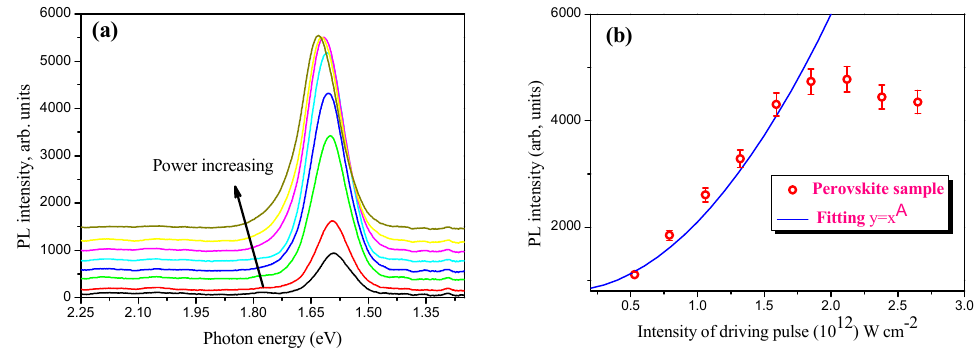
Figure 4. Power − dependent PL signal excited in the thin film mixed perovskite. ( a ) Power-dependent blue − shifted PL signal at the wavelength of 779.8 nm to 758.1 nm. The black arrow shows blue-shift of the PL peak. ( b ) Quadratic dependence (A = 2) of the PL emission integrated intensity on the intensity of the driving laser pulses at low excitation power is observed at 50 kHz repetition rate. The experimental data are presented by the red open circles and theoretical fitting is presented by the blue solid